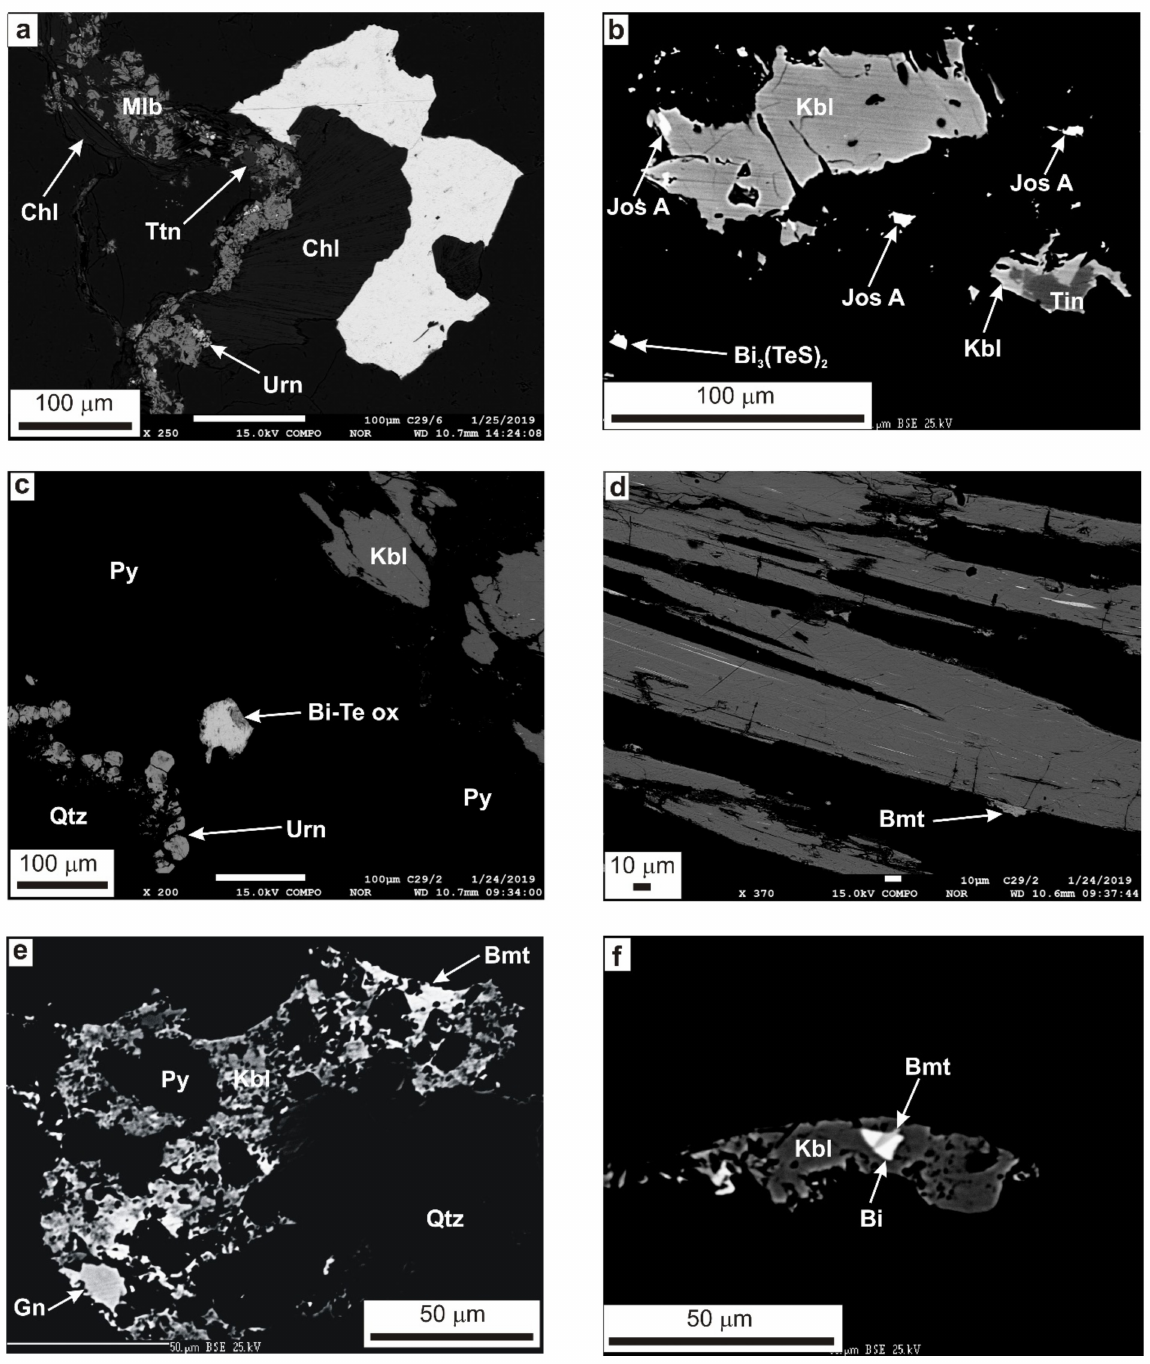
Figure 7. ( a ) Tetradymite aggregate (white) in spatial association with chlorite (Chl), titanite (Ttn), molybdenite (Mlb) and uraninite (Urn). The host mineral is quartz (black). ( b ) Aggregates of kobellite–tintinaite series minerals (Kbl and Tin, respectively) accompanied by jos é ite-A (Jos A) and Bi 3 (TeS) 2 mineral phase (“protojos é ite”) in quartz (black). ( c ) Grain of jos é ite-B (white), rimmed by Bi-Te oxides (Bi-Te ox) in pyrite I (Py). In the top right are grains of minerals of the kobellite–tintinaite series (Kbl), and in the bottom left is a pyrite aggregate lined with uraninite (Urn). To the left of uraninite is quartz (Qtz). ( d ) Needle-like crystals of kobellite–tintinaite (dark grey) with lamellae of the nameless Bi 3 (Te,S) 2 mineral phase (white) corresponding to the “protojos é ite”. Bismuthinite (Bmt) is grown on kobellite–tintinaite crystals. ( e ) Pyrite (Py) and galena (Gn) are enclosed by kobellite–tintinaite series minerals (Kbl), which overgrows with bismuthinite (Bmt) in quartz (Qtz). ( f ) Bismuthinite (Bmt) overgrown by bismuth (Bi); both are enclosed in kobellite–tintinaite series minerals. Host mineral is quartz (black). BSE, photos by T. Mikuš ( a , c , d ) and M. Števko ( b , e , f